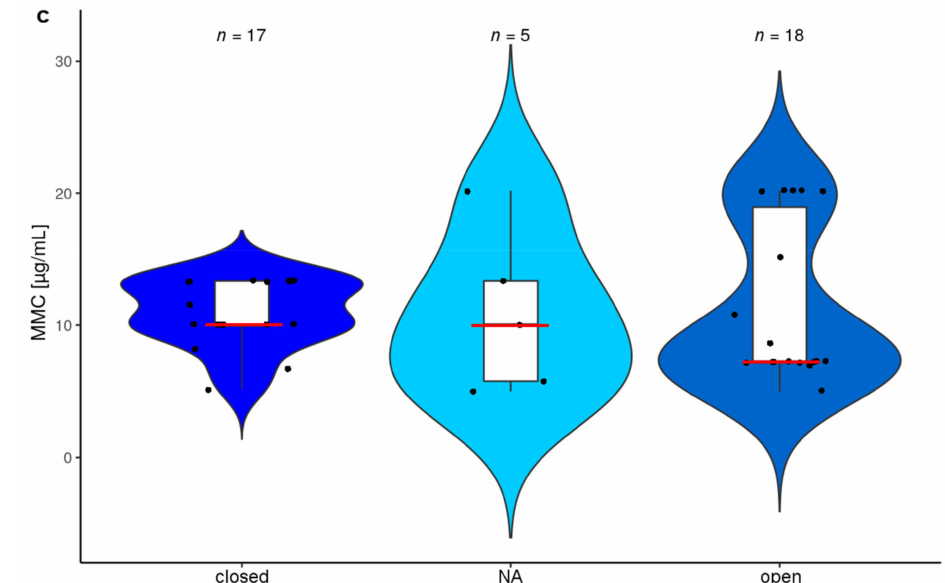
Figure 12. Overview on drug diluent volumes and drug concentrations for L-OHP and MMC according to open and closed HIPEC technique: The violin plots depict protocols categorized according to open/closed or missing/ambiguous information (NA), reporting ( a ) volumes of solutions used to dilute drugs employed for HIPEC (Median volumes (L): open: 3.2; closed: 3.0; NA: 3.5) or ( b ) the resulting concentrations of L-OHP (Median drug concentrations ( µ g/mL): open: 230; closed: 202; NA: 230) and ( c ) MMC (Median drug concentrations ( µ g/mL): open: 7.2; closed: 10; NA: 10). Since there is lacking uniformity and for comparative reasons, we imputed data to a presumed average patient (with characteristics of 1.7 m height, 70 kg weight and 1.73 m 2 body surface area). Further, in case of ambiguity values were maximized using the maximal drug amounts and the minimum volumes reported. The red bars mark medians and white boxes interquartile range. Protocols with missing data or reporting ≤ 4 patients and the outlier [121] were omitted. Abbreviations used: L-OHP (oxaliplatin); MMC (mitomycin c); NA (not